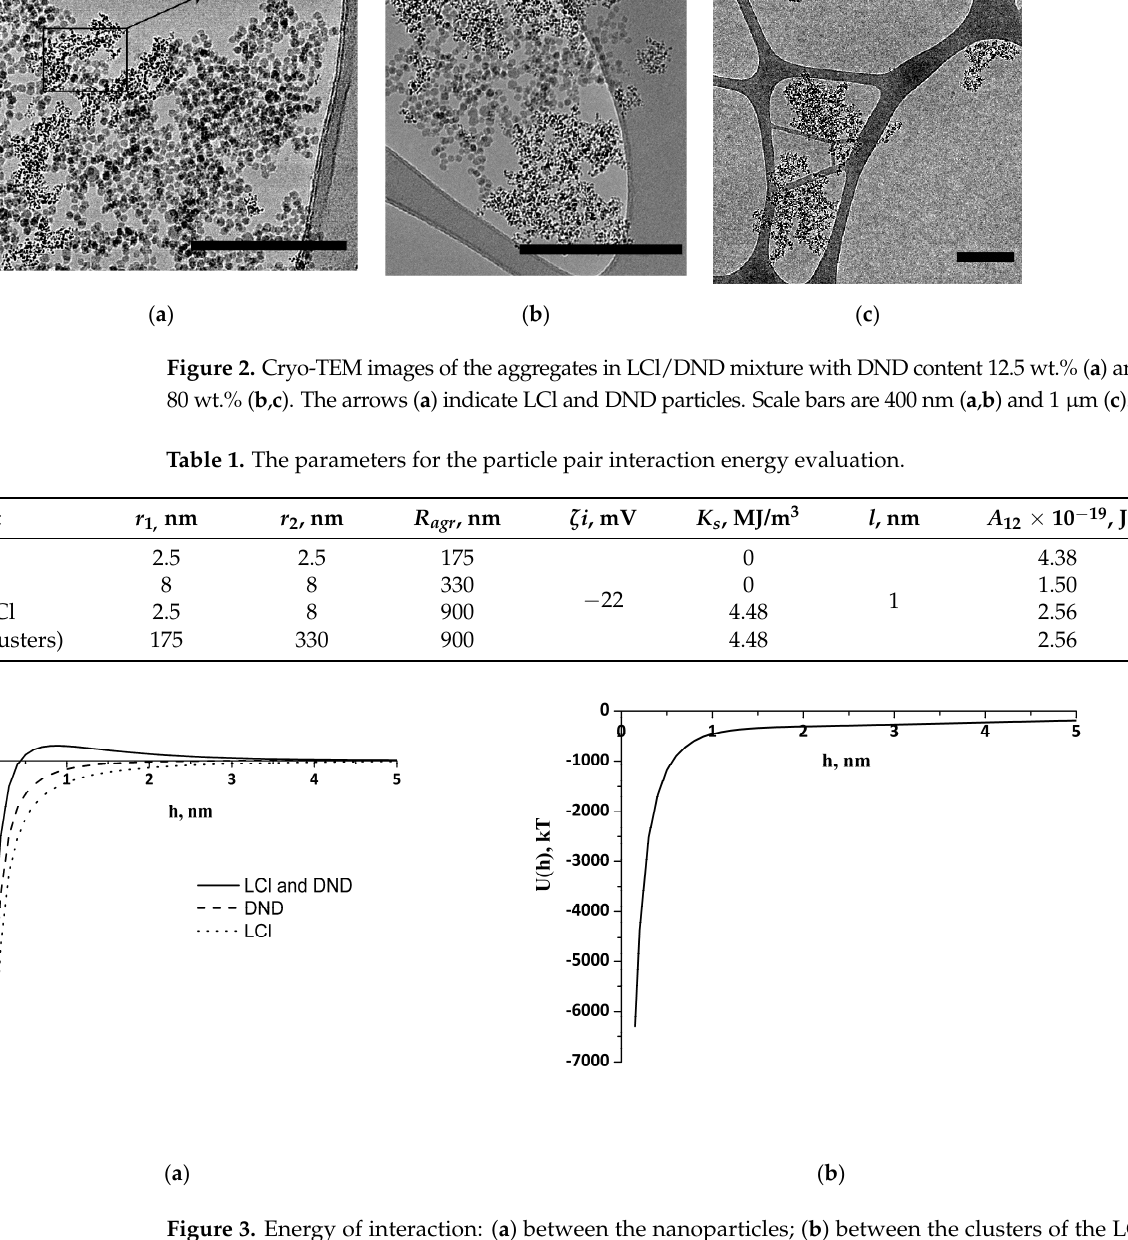
Figure 4. Scheme of stabilization of the direct emulsion by the LCl/DND mixture. Coalescence-resistant Pickering emulsion was obtained by stabilizing soybean oil droplets with a mixture of LCl and DND nanoparticles. The size of colloidosomes (drop- lets of the oil phase with the nanoparticle shell) depends on the DND content in the mix- ture of nanoparticles (Figure 5a). It was found that the colloidosome diameter at a DND concentration of 10–50 wt.% is about 2 μ m. The further increase of DND concentration up to 80 wt.% leads to a decrease of the average diameter of colloidosomes to 750 nm (Figure 5b) followed by growth to 4–4.5 μ m with a subsequent increase of DND content in the mixture.